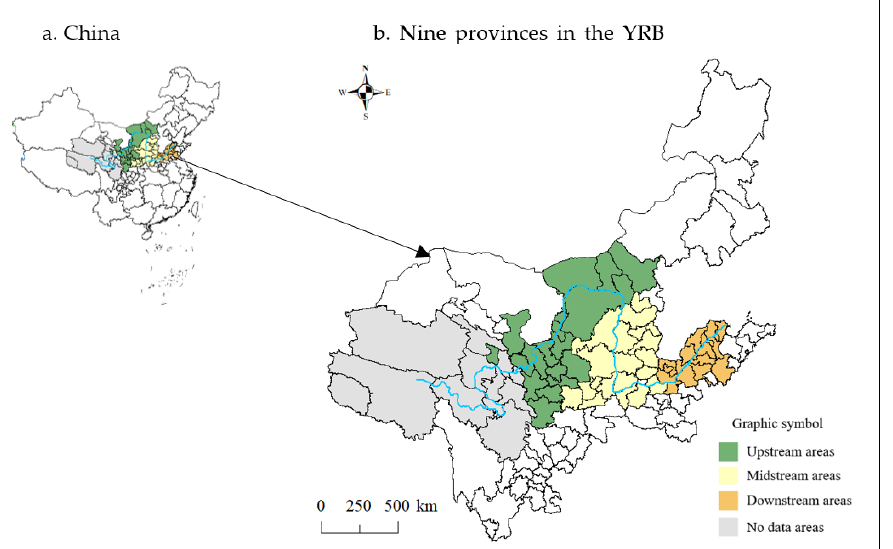
Figure 1. Overview of the distribution of cities along the YRB. Table 1. Distribution of cities in the upper, middle and lower reaches of the YRB.